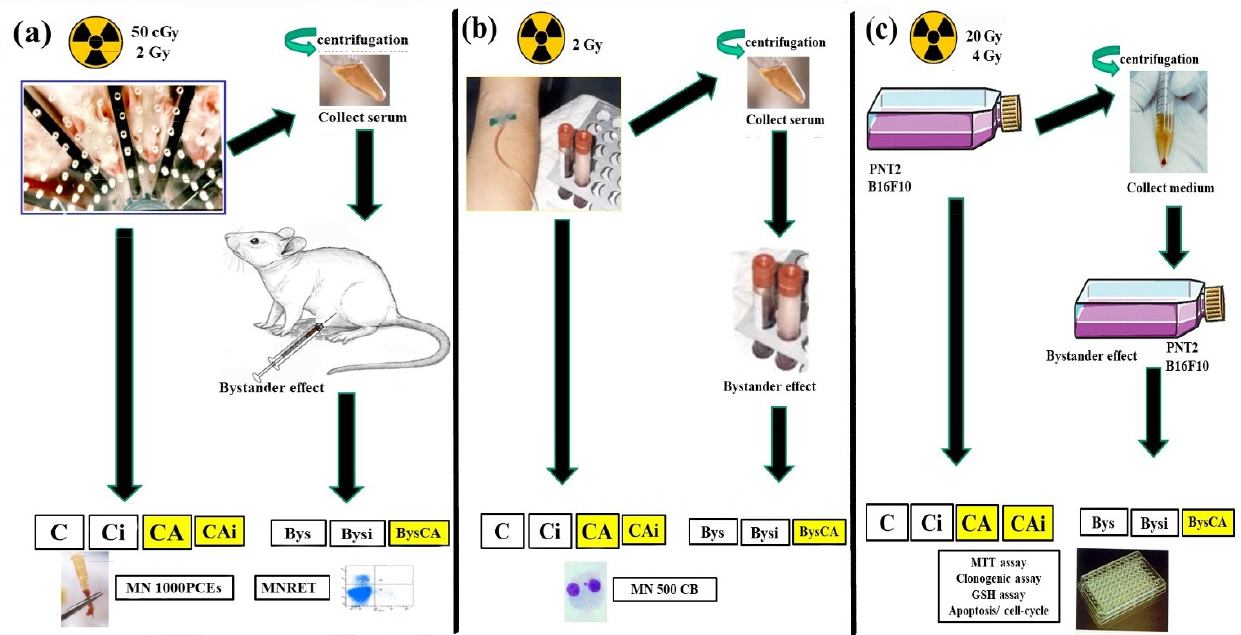
Figure 2. Experimental design of the study: ( a ) In vivo micronucleus assay (in mouse bone marrow (MNPCEs) and reticulocytes (MNRET)); ( b ) In vitro micronucleus assay (MNCB); ( c ) Survival cell assay (MTT cytotoxicity assay, clonogenic assay, GSH assay, and apoptosis (C, control; CA, treated with carnosic acid; Ci, irradiated control; CAi, irradiated previously treated with carnosic acid; Bys, treated with serum/medium non irradiated; Bysi, treated with serum/medium previously irradiated; BysCA, treated with irradiated serum/medium previously treated with carnosic acid).